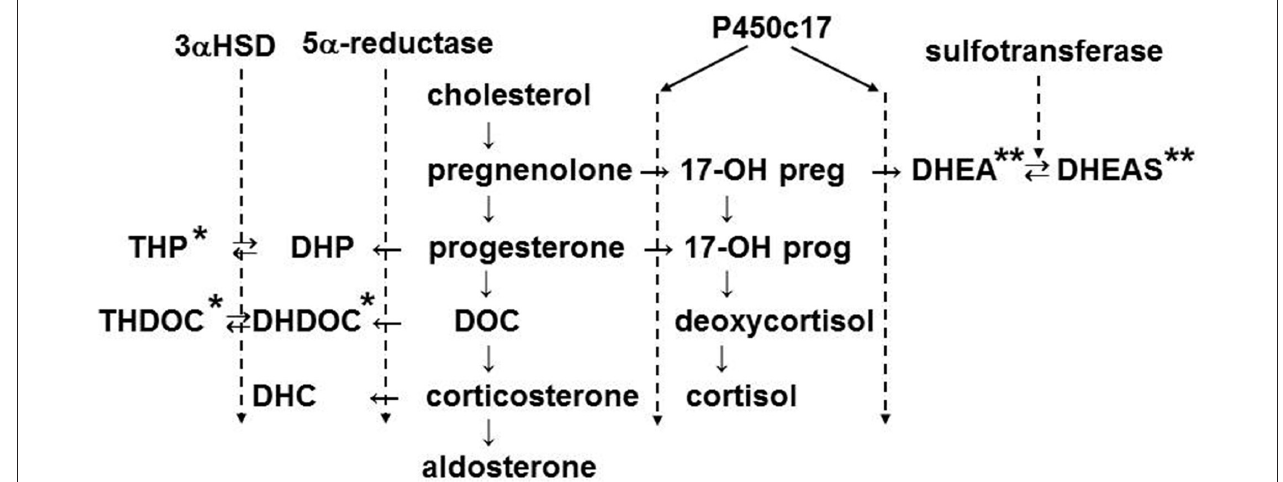
FIGURE 4 | Biosynthetic pathway of adrenal steroids . The enzymes shown mediate the conversion of steroids in the indicated step(s). The names of steroids are abbreviated: THP, 3 α , 5 α -tetrahydroprogesterone or allopregnanolone; DHP, 5 α -dihydroprogesterone; THDOC, 3 α , 5 α -tetrahydrodeoxycorticosterone; DHDOC, 5 α -dehydrodeoxycorticosterone; DHC, dehydrocorticosterone; DOC, 11-deoxycorticosterone; 17-OH preg, 17-OH pregnenolone; 17-OH prog, 17-OH progesterone; DHEA, dehydroepiandrosterone; DHEAS, DHEA sulfate. 3 α HSD, 3 α -hydroxysteroid dehydrogenase. The steroids marked by single and double asterisks are positive and negative allosteric modulators of GABA A receptors, respectively.